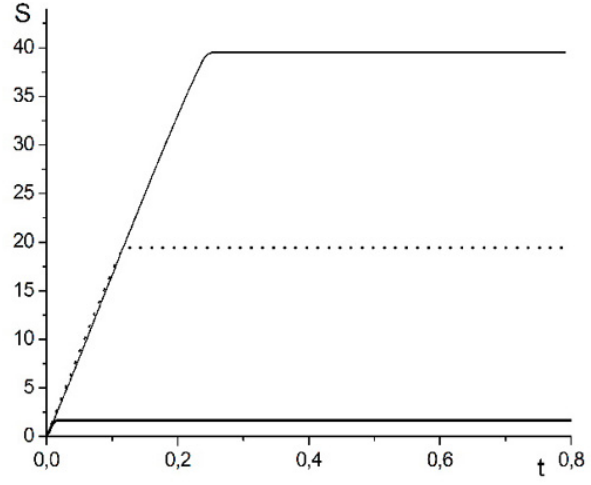
Fig. 8. Amplification factors versus time for the same three rays as in Fig. 6.